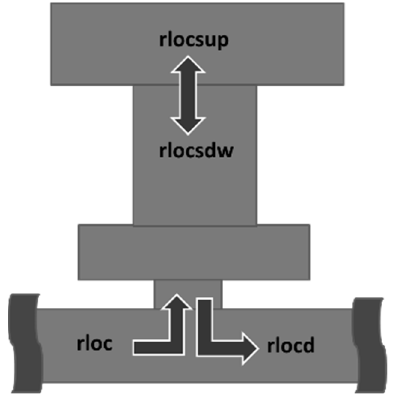
Figure 3. Local head loss coefficients in the surge